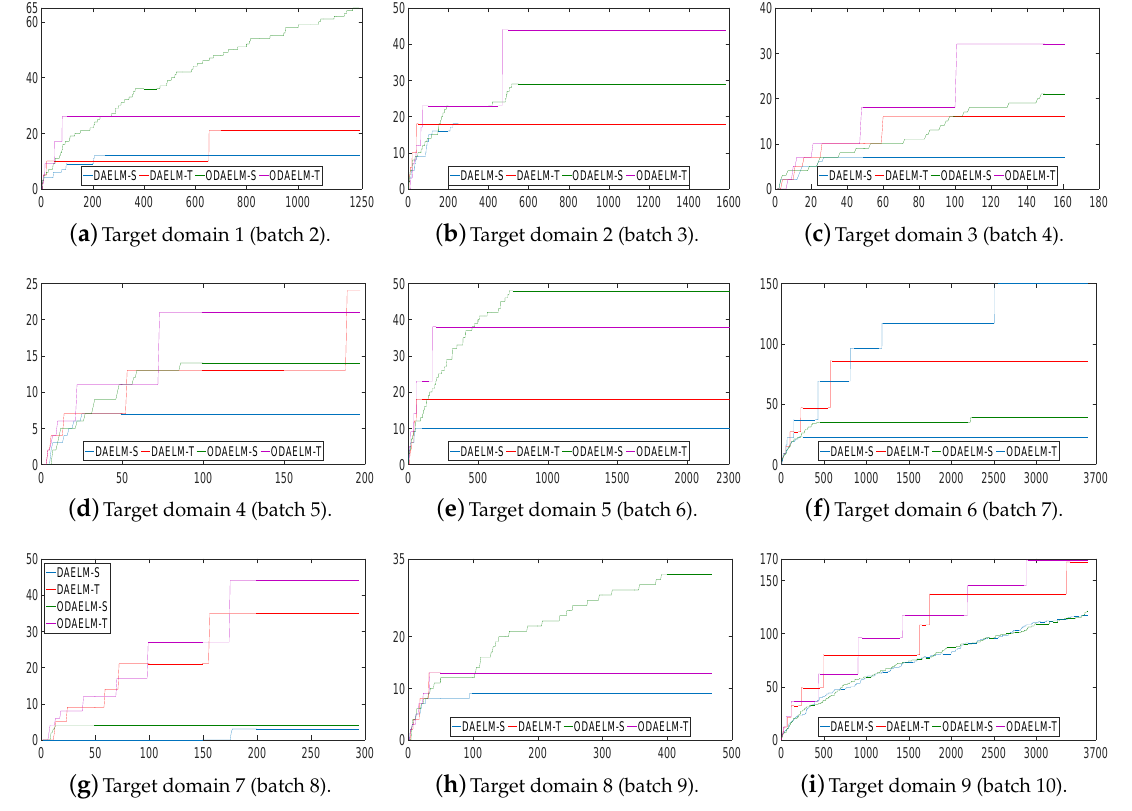
Figure 10. Numbers of labeled samples in nine target domains using setting 2. The y -axis is the number of labeled samples and the x -axis is the index of